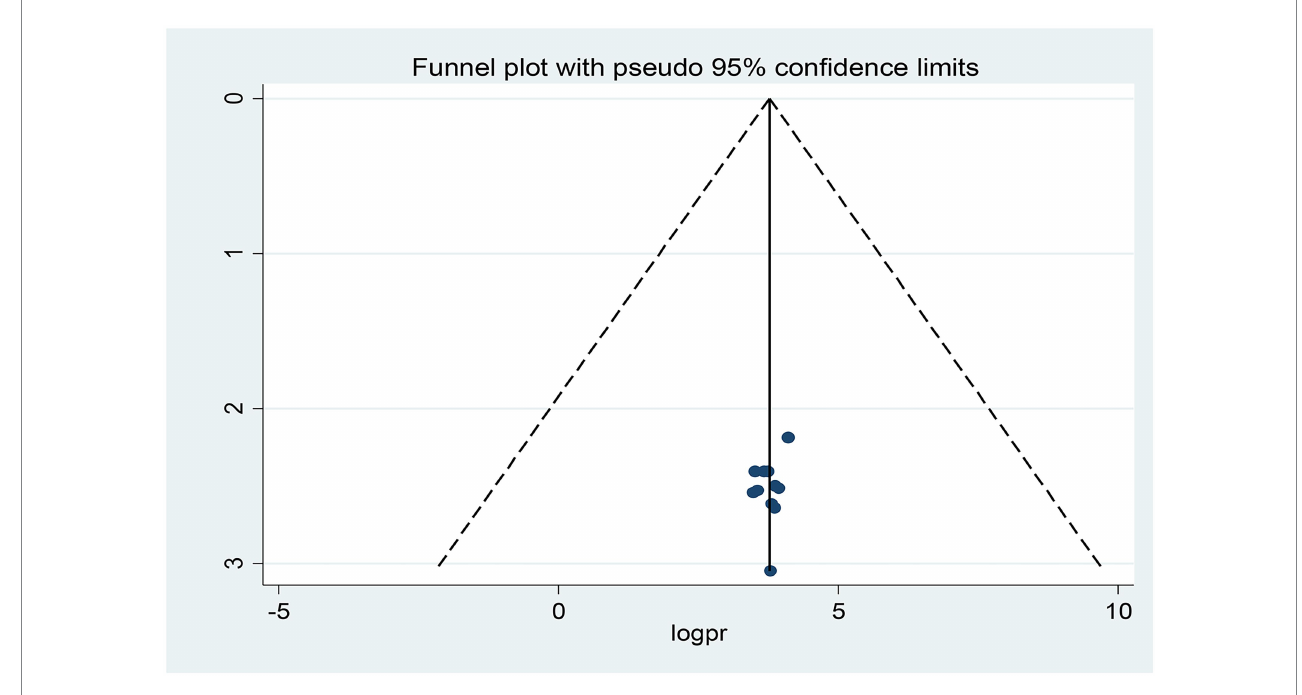
FIGURE 5 Funnel plots for exploring publication